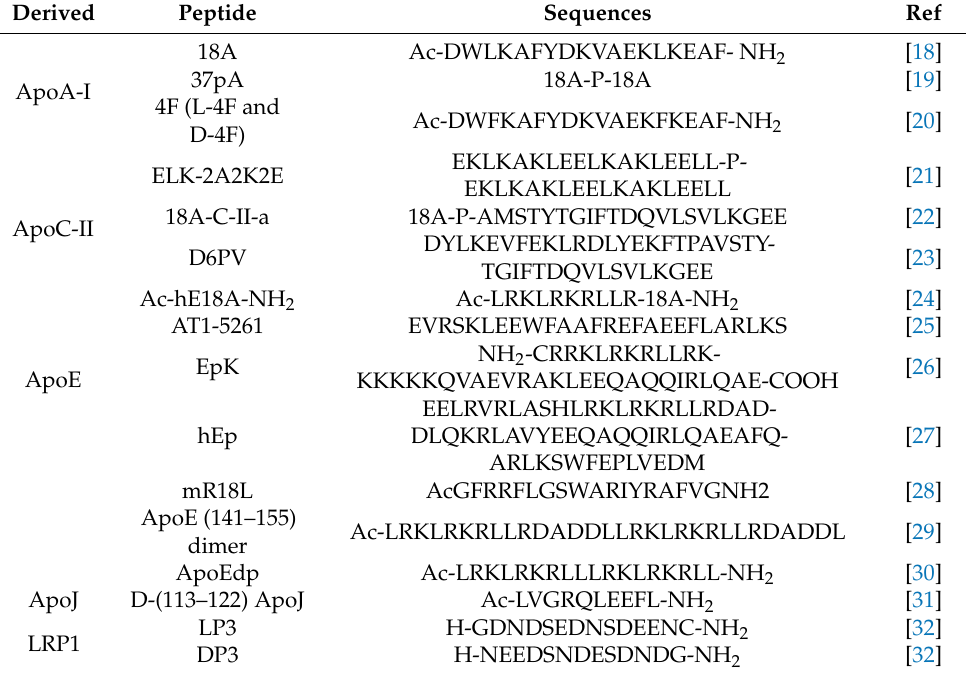
Table 1. Apolipoprotein and LRP1-based peptides